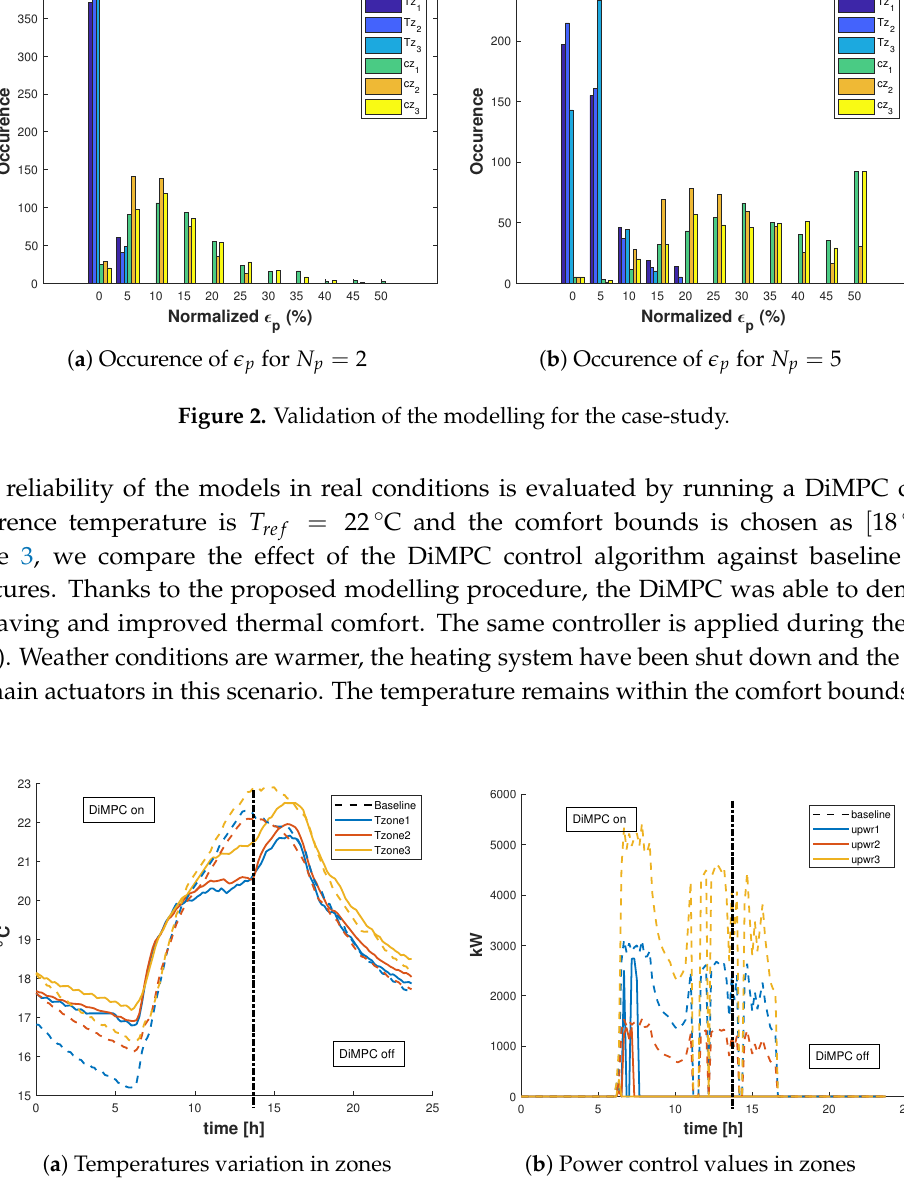
Figure 3. Comparison between DiMPC (plain lines) and baseline (dash line) control algorithms during winter: DiMPC is enabled during 14 h then